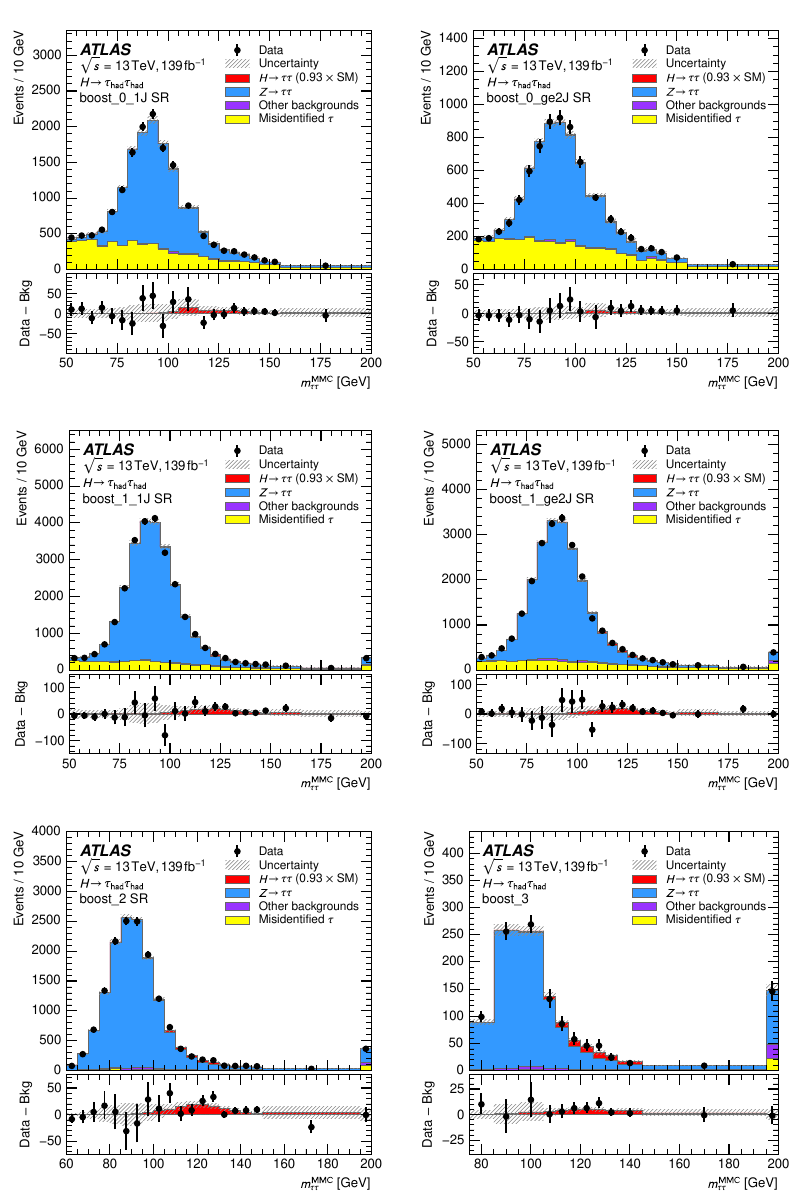
Figure 20. Distribution of the reconstructed ττ invariant mass ( m MMC ) for all events in the boost ττ categories of the τ τ channel. The bottom panel shows the differences between the numbers of had had observed data events and expected background events (black points). The observed Higgs boson signal, corresponding to ( σ × B ) / ( σ × B ) = 0 . 93 , is shown with a filled red histogram. Entries SM with values above the x -axis range are shown in the last bin of each distributions. The dashed band indicates the total uncertainty on the total predicted yields. The prediction for each sample is determined from the likelihood fit performed to measure the pp → H → ττ